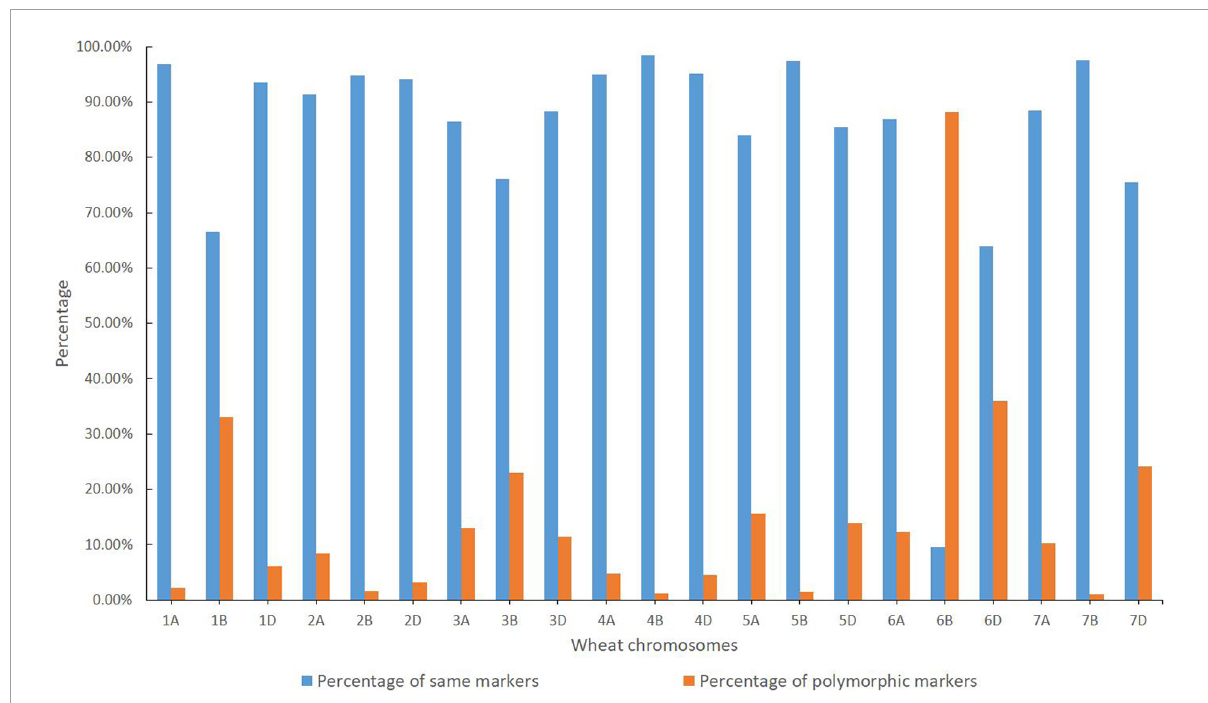
FIGURE2 Wheat 55K SNP array analysis. Orange and blue colors indicate the percentages of the same and polymorphic SNP loci in each chromosome in the total number of SNP loci between CH51 and wheat parent Jintai 170, respectively.